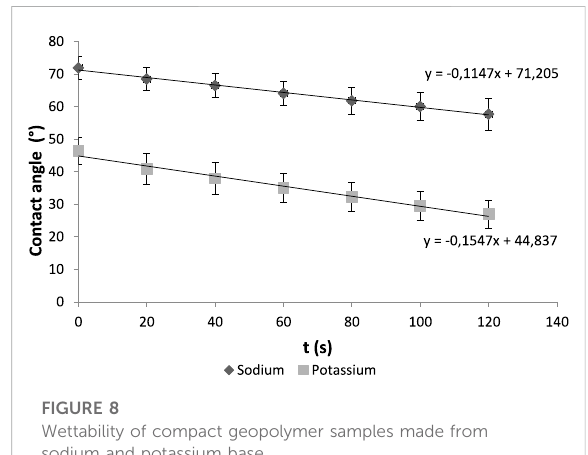
FIGURE 6 Wettability of compact geopolymer with and without high- carbon fl y ash (sodium-based geopolymer).